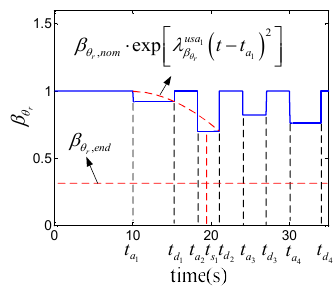
Figure 13. Fault profile in β θ r . Actuators 2020 , 9 , x FOR PEER REVIEW